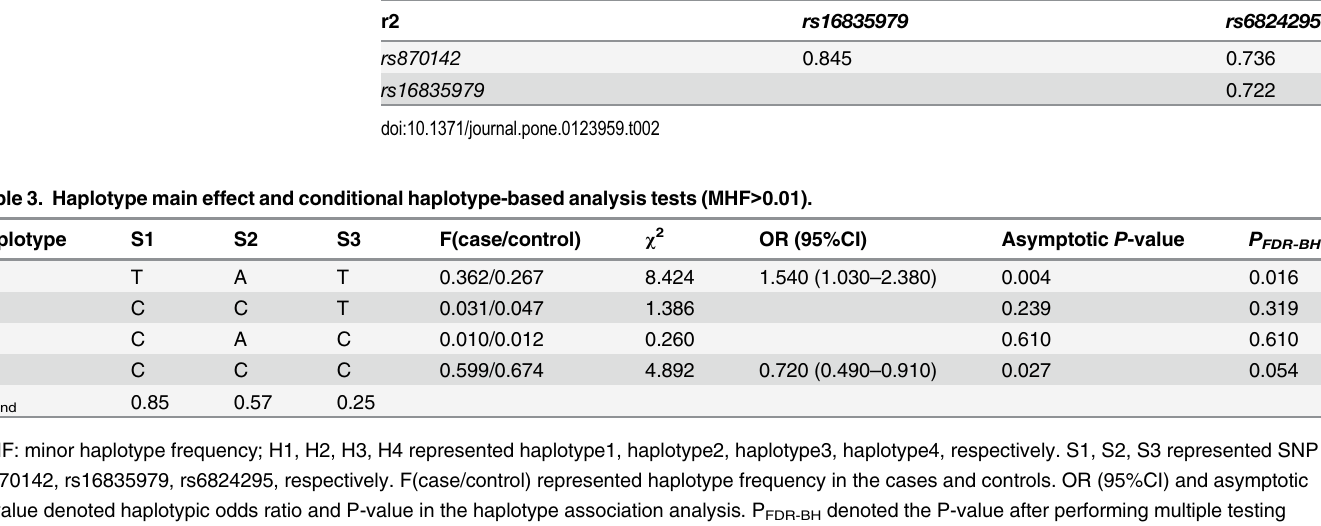
Table 2. Results of linkage disequilibrium analysis among the 3 SNPs at chromosome4p16.